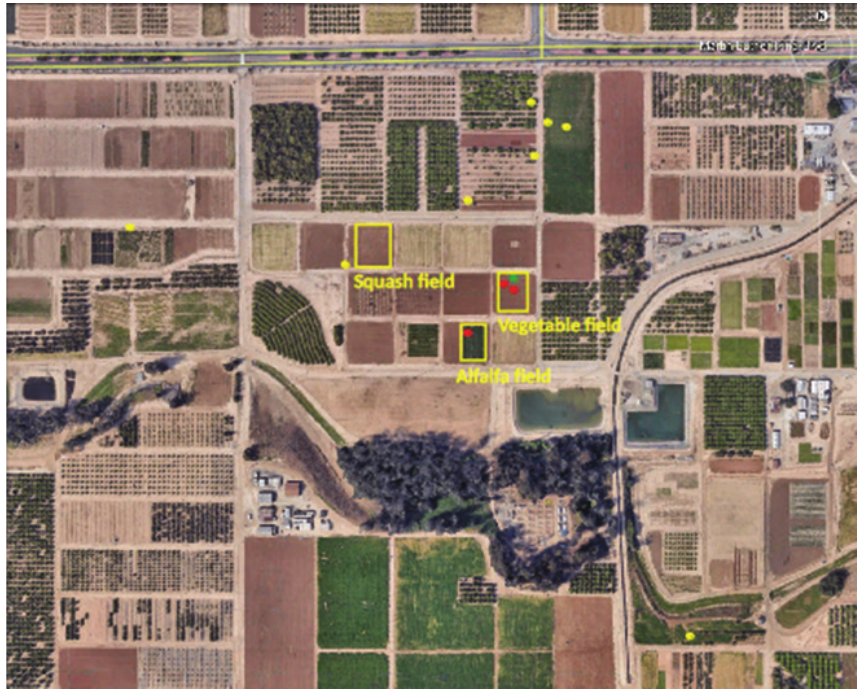
Figure 1. Locations at the Agricultural Operations of the University of California, Riverside that were selected to survey for resident egg parasitoids of Bagrada hilaris . Yellow squares show the host fields that included squash: Latitude 33°57'58.08"N, Longitude 117°20'35.37"W; alfalfa: Latitude 33°57'54.20"N, Longitude 117°20'27.01"W; and mixed vegetables: Latitude 33°57'56.32"N, Longitude 117°20'25.48"W. Yellow dots show other locations where mustard weeds were found and sentinel cards were placed. The green dot represents the location where Trissolcus hyalinipennis was recovered and the red dots represent the locations where Trissolcus basalis was